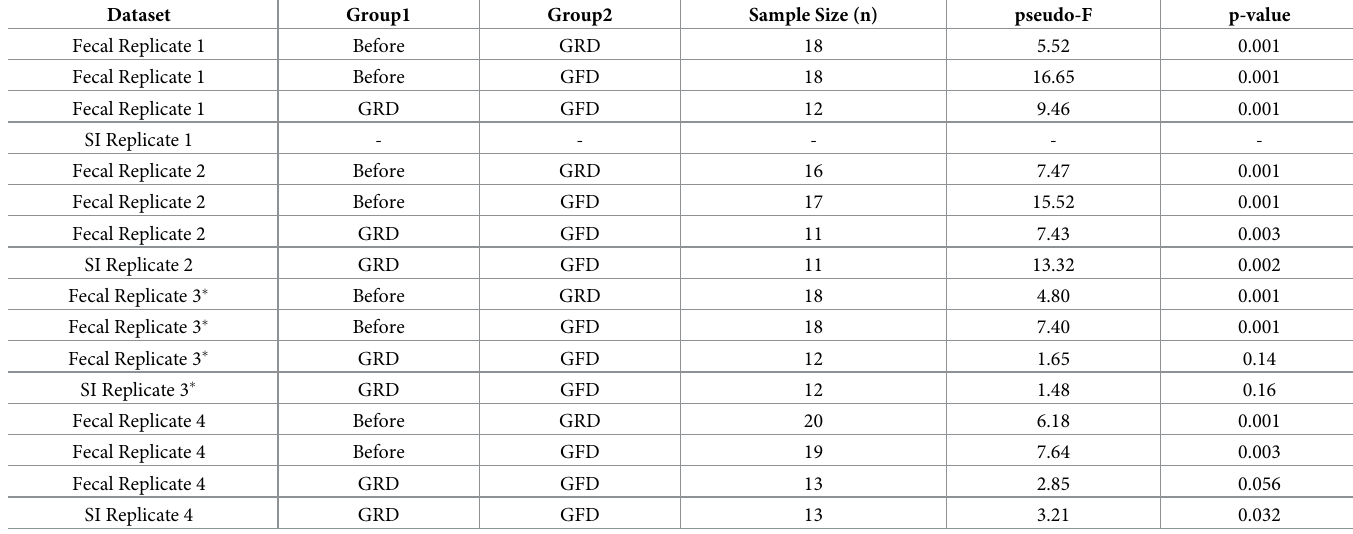
Table 1. PERMANOVA results of β -diversity analyses (Bray-Curtis).